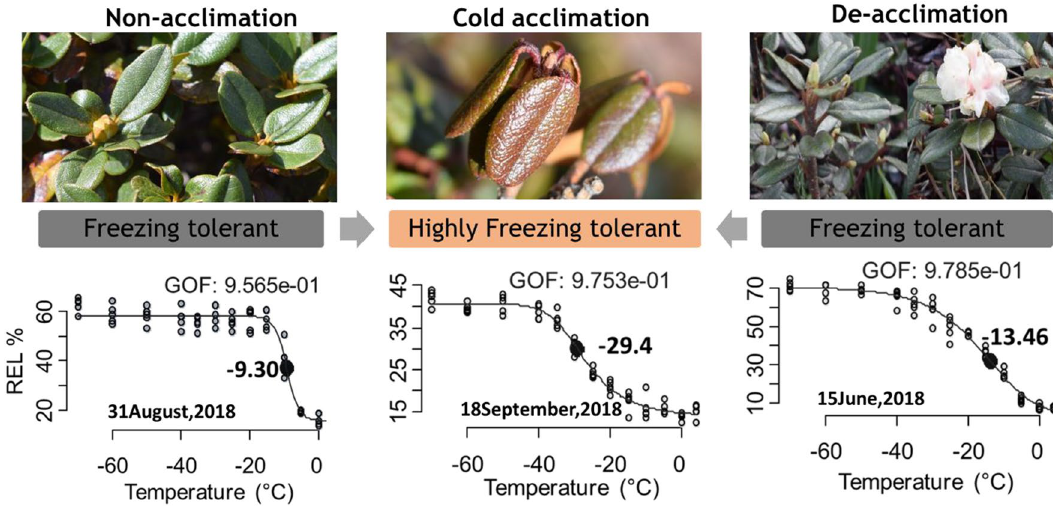
Figure 1. LT50 [black point (with solid fill) on the curve] calculated by fitting sigmoidal curve to relative electrolyte leakage (REL %) values recorded during the three different acclimation phases. GOF indicates ‘goodness of fit’ test values for the fitted sigmoidal curves.